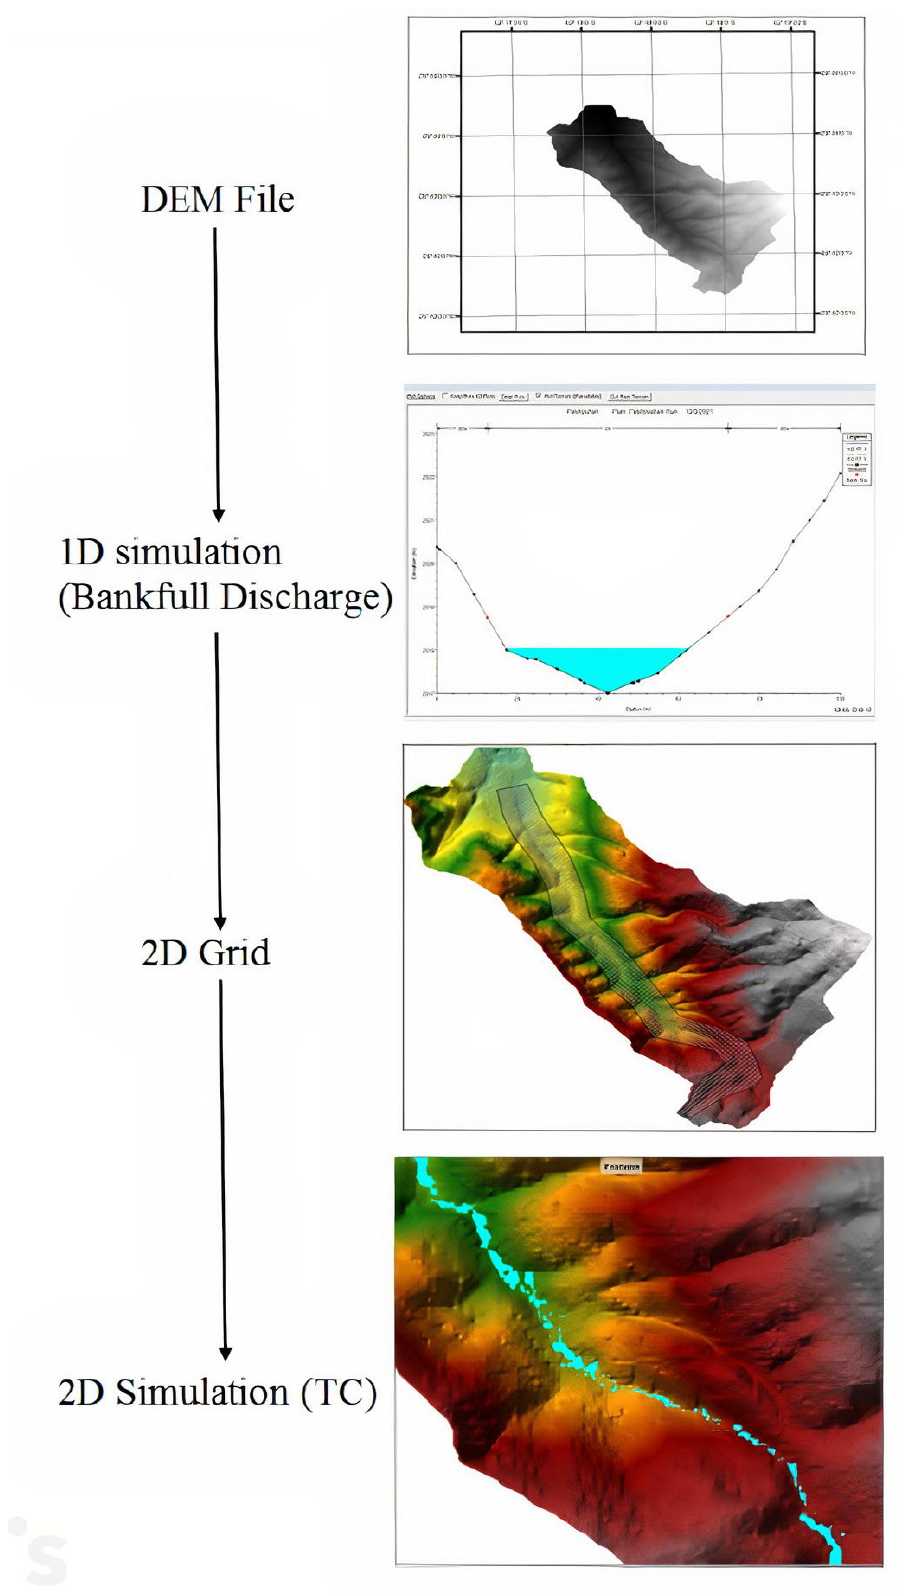
Figure 2. Flowchart describing the proposed procedure for calculating